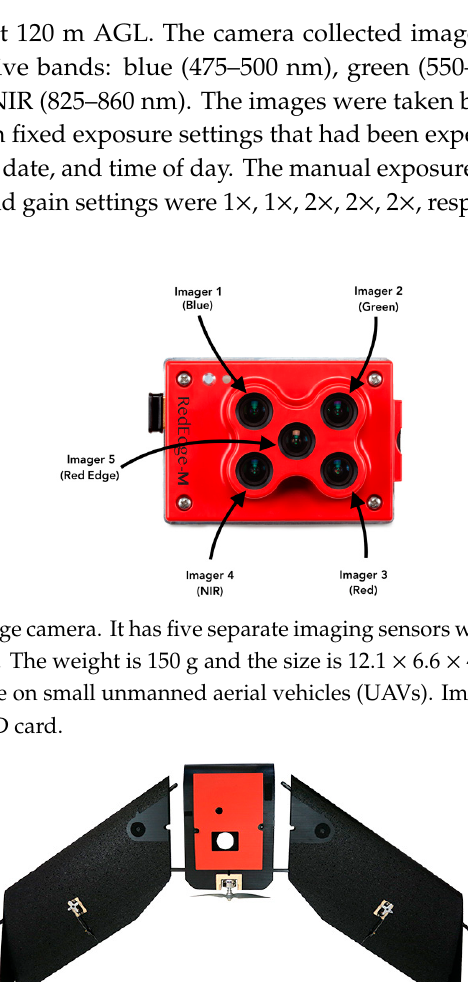
Figure 3. Fixed-wing UAV “TuffWing UAV Mapper.” The aircraft body is made of expanded polypropylene (EPP) foam with reinforcing carbon fiber spars, so it is strong with low mass to maximize flight time. Including the Micasense RedEdge camera, the weight is about 2 kg, and the wingspan is 1218 cm. At the manufacturer-reported flying endurance of 40 min, the Tuffwing can cover 275 acres at 100 m above-ground level (AGL).